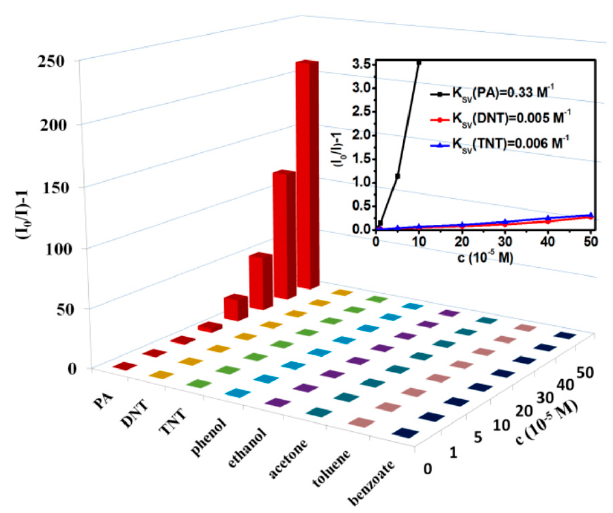
Figure 19. Quenching e ff ects of a range of compounds in aqueous dispersions of C-dots at a range of concentrations, showing high selectivity for PA. Reproduced from reference [80] with permission from The Royal Society of Chemistry.